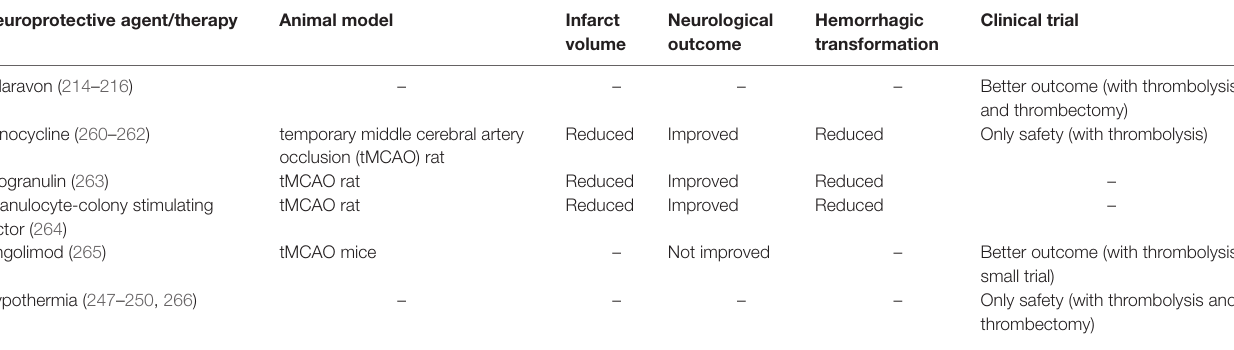
TAbLe 2 | Combined therapy with acute recanalization against ischemia-induced inflammation and reperfusion injury in experimental stroke models and clinical trials. Neuroprotective agent/therapy Animal